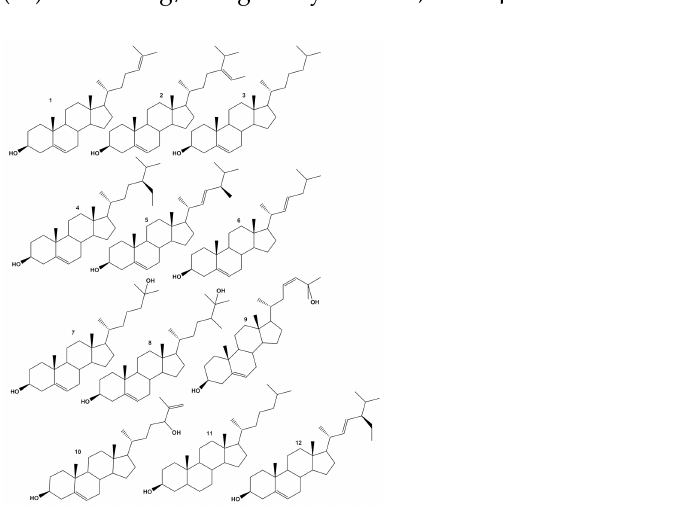
Figure 1. Chemical structures of sterols identified in Asparagospis